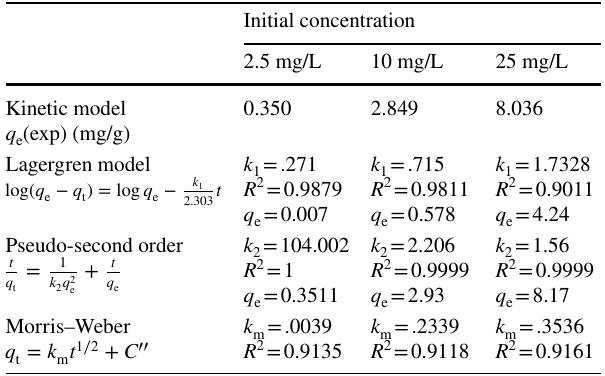
Table 4 Values of different parameters in kinetic model (varying ini- tial concentrations)